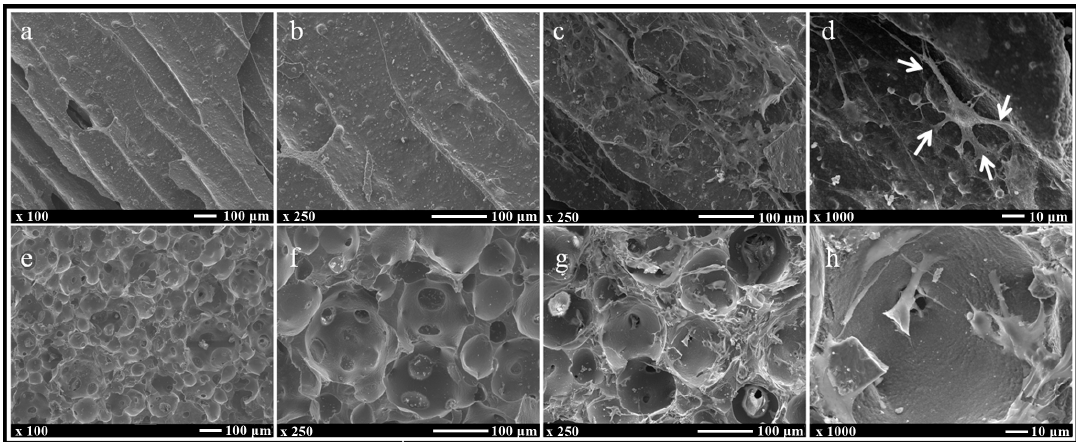
Figure 4. SEM images with and without cells. ( a , b ) UDPHAp and ( e , f ) IP-CHA without cells; ( c , d ) UDPHAp and ( g , h ) IP-CHA with MC3T3-E1 cells attached onto each surface of the scaffold. White arrows indicate filopodia. White bars represent 100 µm ( a – c and e – g ) and 10 µm ( d , h ).